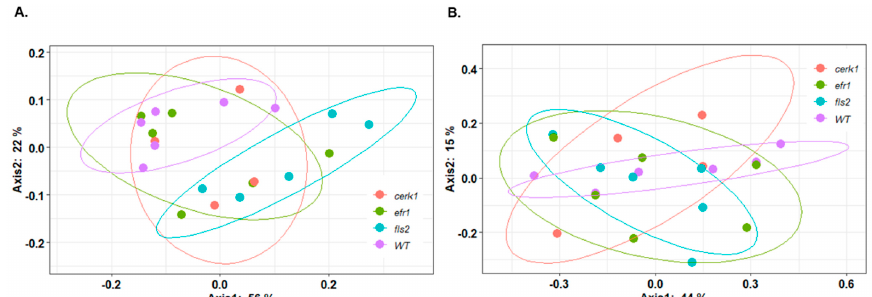
Figure 6. Principal coordinate analysis (PCoA) of microbial β -diversities based on weighted unifrac taxa abundances for bacterial ( A ) and fungal ( B ) samples obtained from rhizosphere of Arabidopsis PAMP mutants ( cerk1 , efr1 , and fls2 ) and the wild-type (WT; Col-0). Distances between circles on the ordination plot reflect dissimilarities in bacterial and fungal community structure. Different colors denote different genotypes